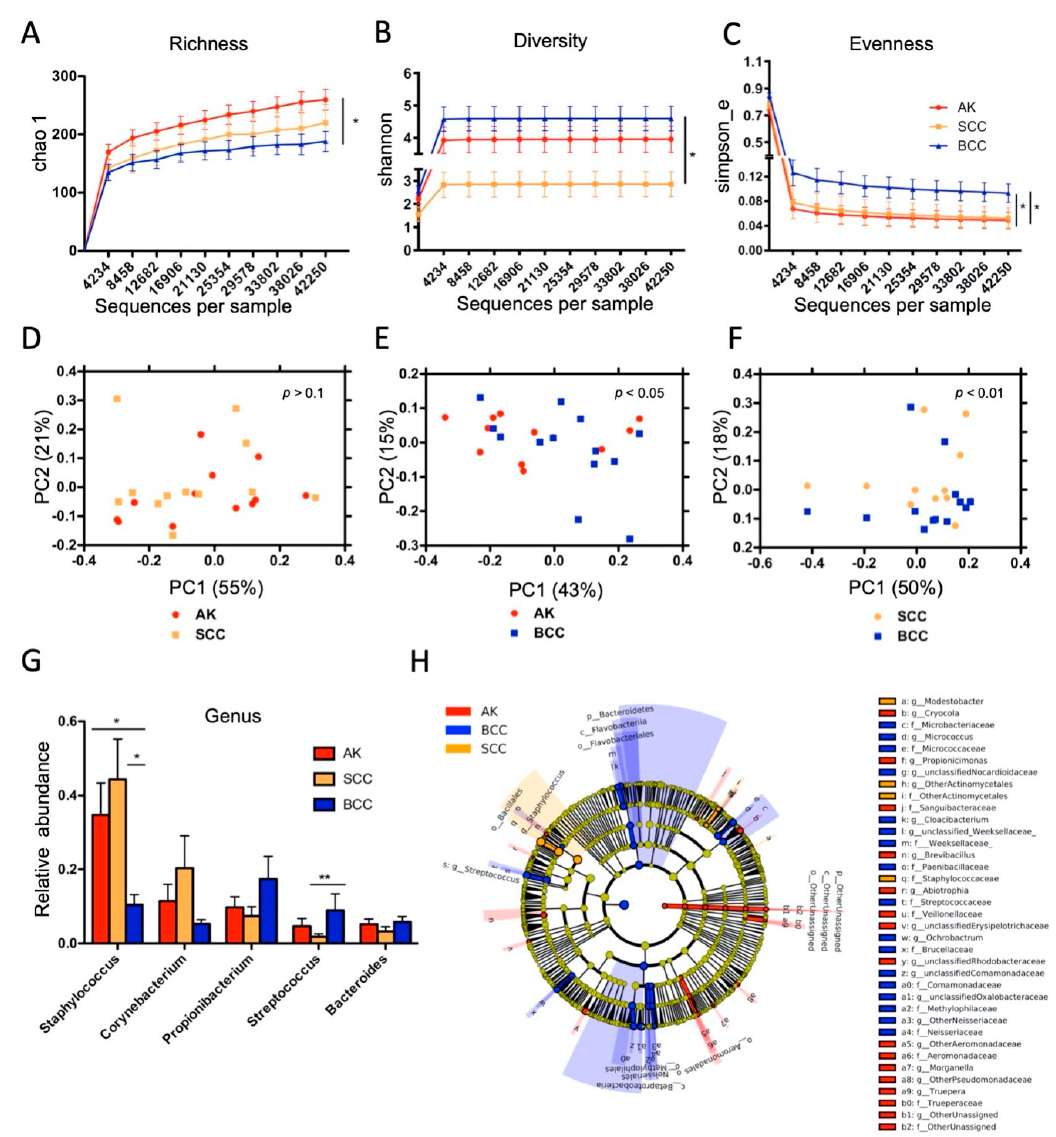
Figure 2. Di ff erent microbial community types in keratinocyte skin tumors. ( A ) Microbial richness (Chao1) was significantly higher in AK compared to BCC and ( B ) diversity (Shannon) was significantly lower in SCC compared to BCC. ( C ) Evenness (Simpson) was significantly lower in AK and SCC compared to BCC (unpaired t -test; * p < 0.05). ( D – F ) Principal coordinate analysis indicates significantly di ff erent microbial communities in AK and SCC compared to BCC (measure: weighted unifrac; ANOSIM). ( G ) Relative abundance of Staphylococcus was significantly higher in AK and SCC compared to BCC (* p < 0.05), whereas relative abundance of Streptoccocus was significantly increased in BCC compared to SCC (** p < 0.01; Kruskal–Wallis). ( H ) LEfSe analysis specifying taxa with increased relative abundance in tumors. Note the association of Staphylococcus (LDA > 5) with SCC, as well as